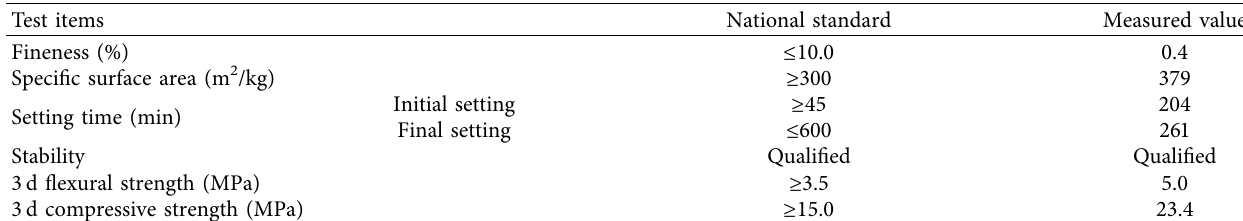
Table 2: Summary of test results of cement physical